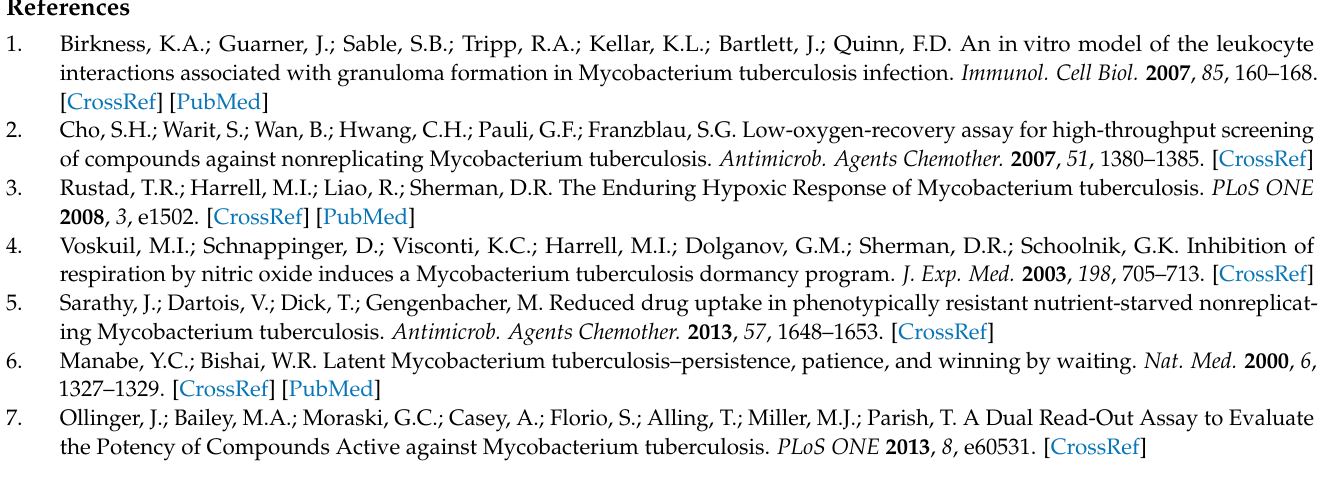
figure subplot (2,1,1) imshow (Image) hold on plot(x,y,‘r’) subplot (2,1,2)